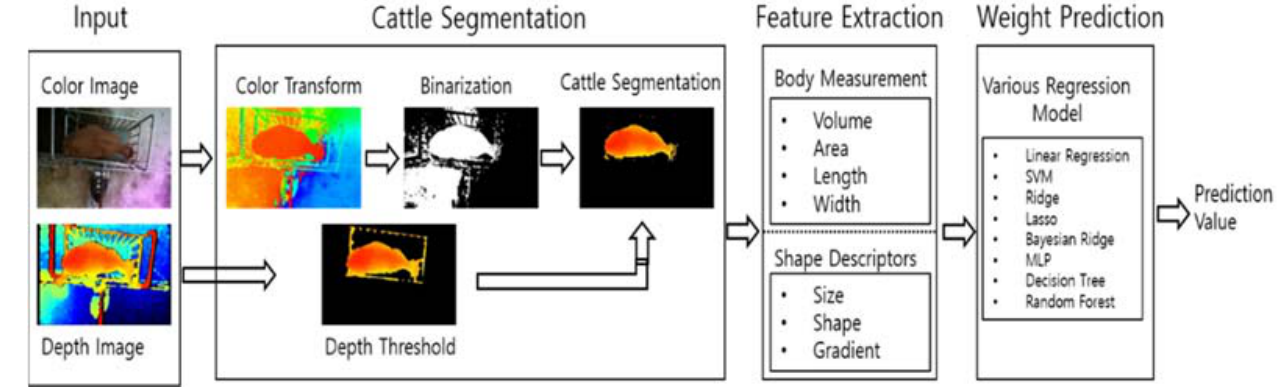
Figure 2. Overview of prediction system for cattle weight.